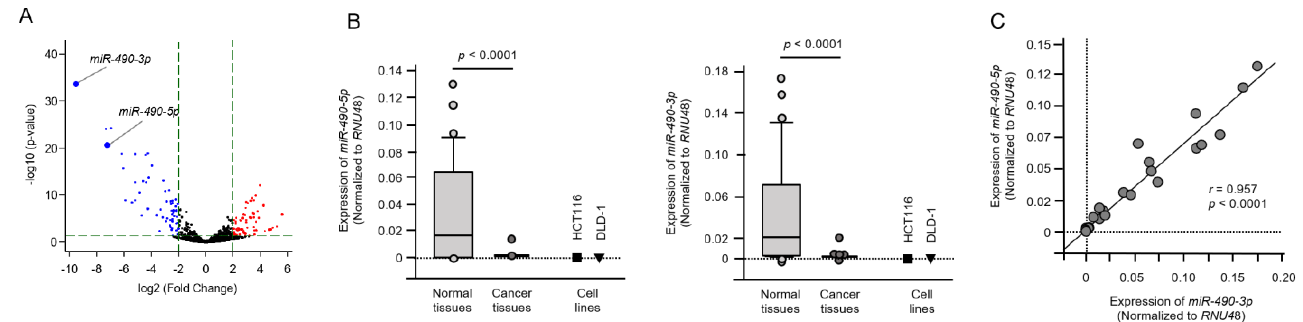
Figure 3. Expression of miR-490-5p and miR-490-3p by small RNA sequencing and expression of miR-490-5p and miR-490-3p in colorectal cancer (CRC) tissues and cell lines. ( A ) Volcano plot of the miRNA expression signature determined by RNA sequencing. The log2 fold-change (FC) is plotted on the x -axis, and the − log10 ( p -value) is plotted on the y -axis. The blue points represent the downregulated miRNAs with an absolute − log2 FC ≥ 1 (FC = 2) and p -value < 0.05. ( B ) The expression levels of miR-490-5p and miR-490-3p , by quantitative polymerase chain reaction, were evaluated in CRC clinical tissues and cell lines (HCT116 and DLD-1). Expression levels of these miRNAs were significantly reduced in cancer tissues ( p < 0.001). ( C ) Spearman’s rank test showed positive correlations between the expression levels of miR-490-5p and miR-490-3p in clinical specimens ( r = 0.957, p < 0.001).